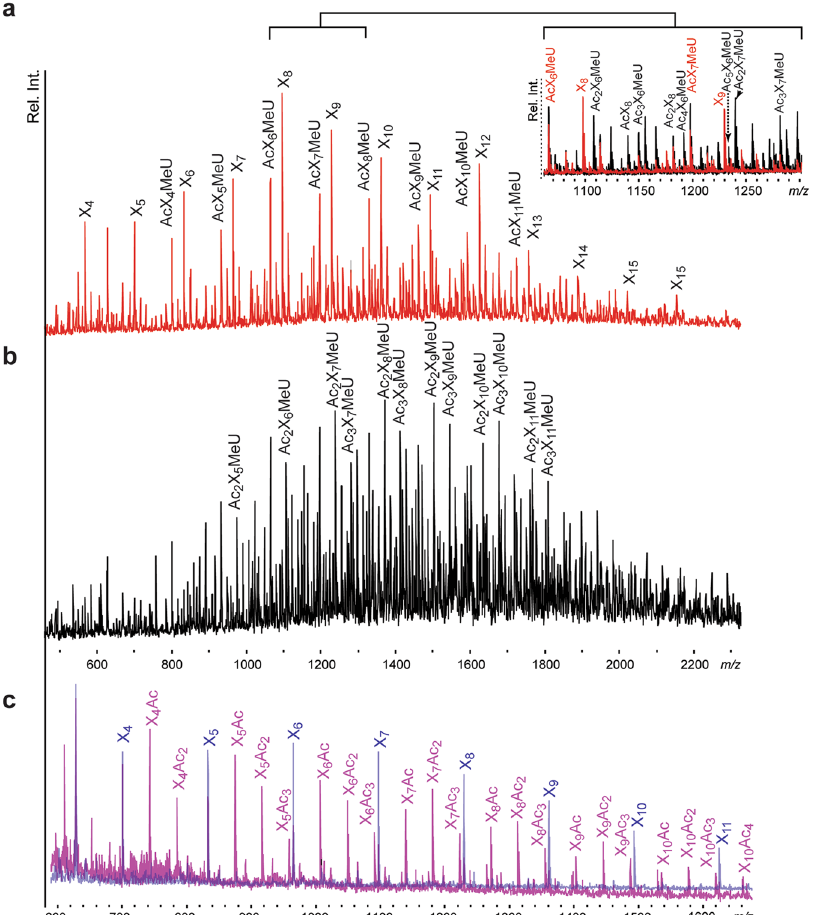
Figure 2. Activity of An CDA on acetylated glucuronoxylan ( a , b ) and acetylated xylan ( c ). The pictures show MALDI-ToF spectra of oligosaccharides. Peaks are labelled by sugar composition; X, xylose; Ac, acetyl group; MeU, 4-O-methylglucuronic acid. Panel a, acetylated glucuronoxylan after treatment with An CDA; panel b, untreated acetylated glucuronoxylan; insert in panel a, comparison of panels a and b; panel c, acetylated xylan before (pink) and after (blue) treatment with An